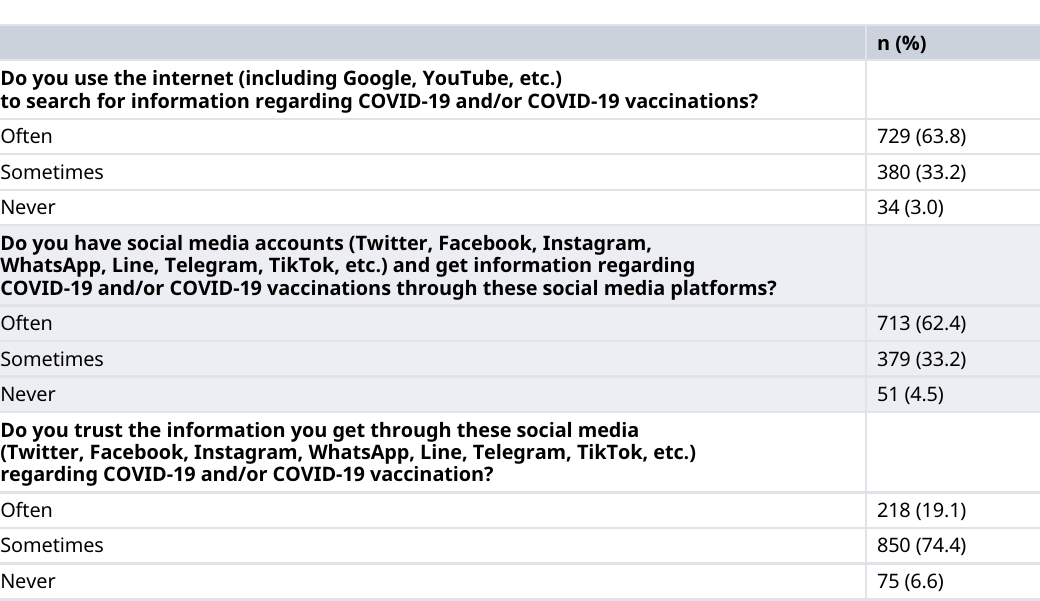
Table 4. Internet and social media use by the